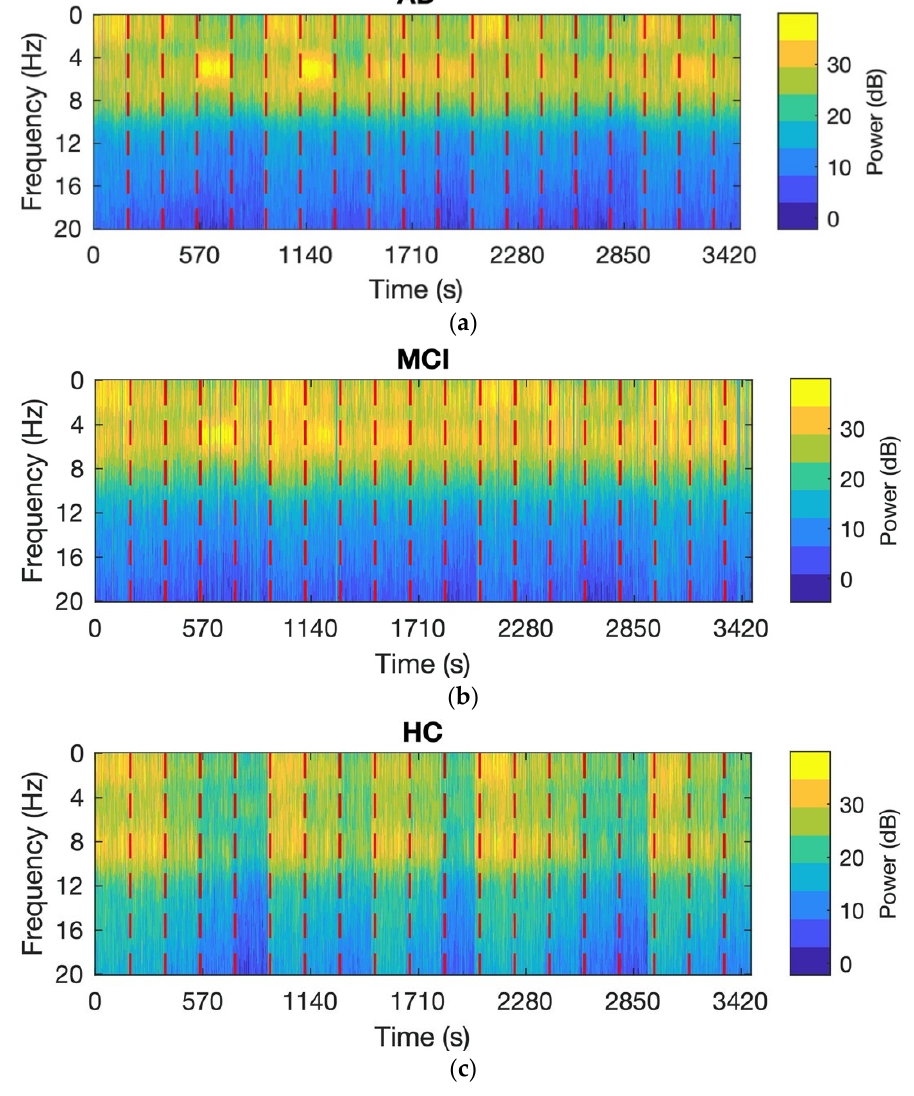
Figure 3. Computed pspectrum from 19 biopotentials (EEG signals) in a frequency range of 0–20 Hz for AD ( a ), MCI ( b ), and HC ( c ). The dashed red line separates each individual signal from the 19 biopotentials that make up the preprocessed EEG signal.